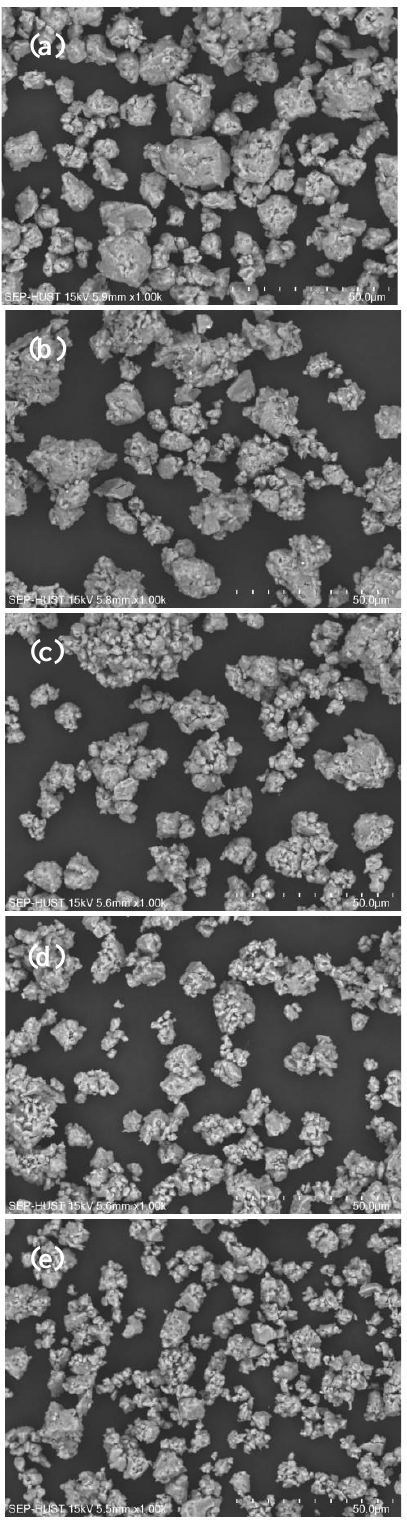
Figure 2. SEM images of Al 82 Fe 14 Ni 4 alloy powders milled at 350 rpm for ( a ) 5 h, ( b ) 10 h, ( c ) 20 h, ( d ) 40 h and ( e ) 60 h.